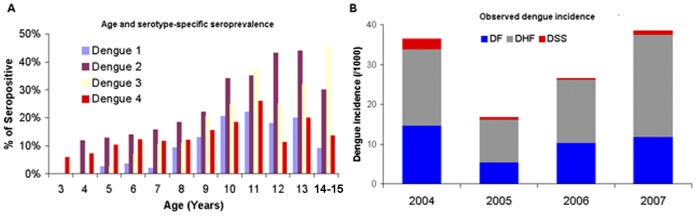
Results of a prospective cohort study in Long Xuen [34].a. Age and serotype specific seroprevalence rate observed in a prospective cohort study performed in An Giang from (2004–2007) b. DF, DHF and DSS incidence observed in 3–15 year-old children.